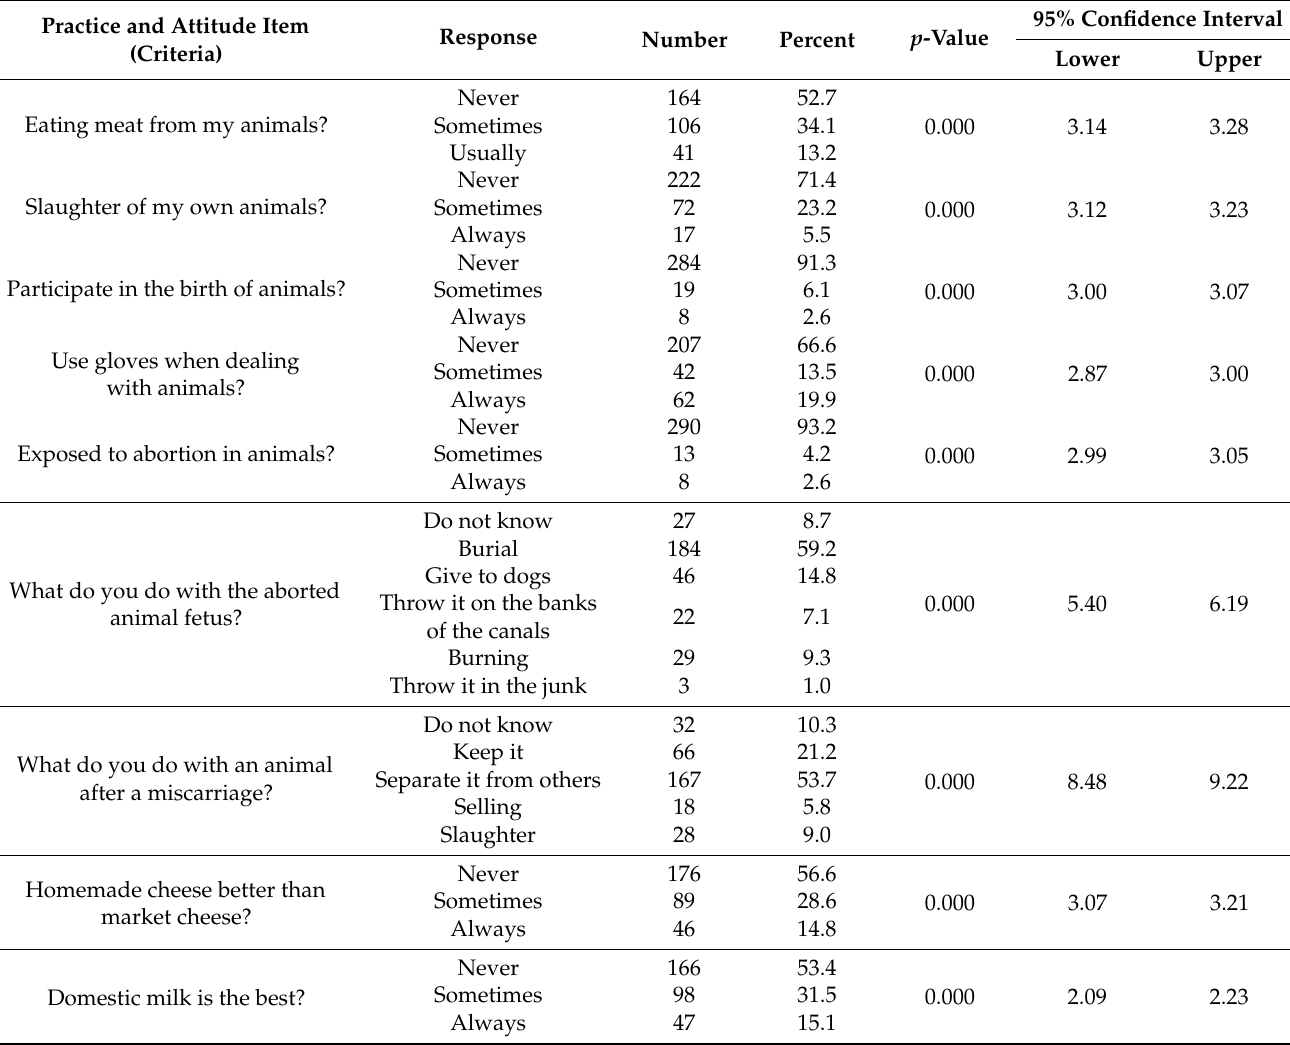
Table 3. Practices and attitudes regarding brucellosis among parents in the Aseer region, southwestern Saudi Arabia. Practice and Attitude